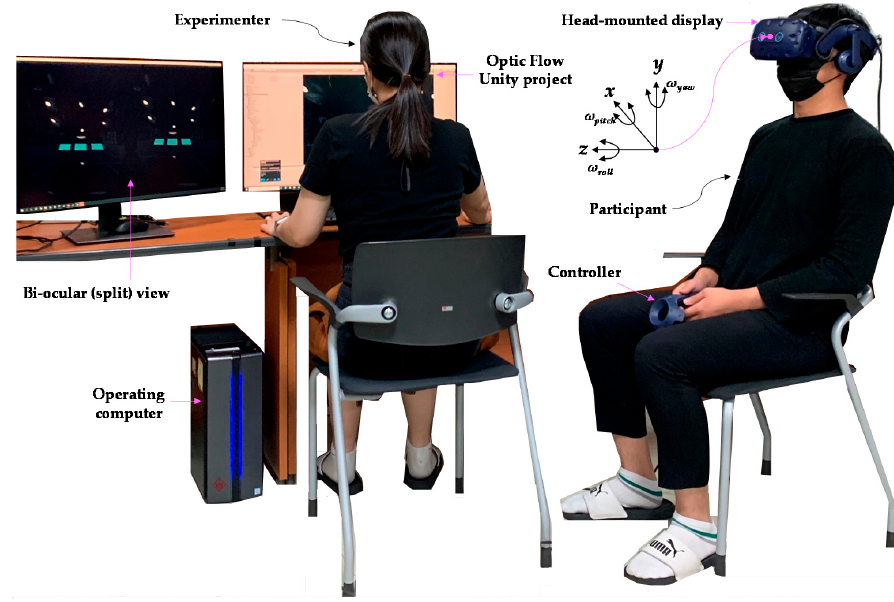
Figure 1. Experimental setup.